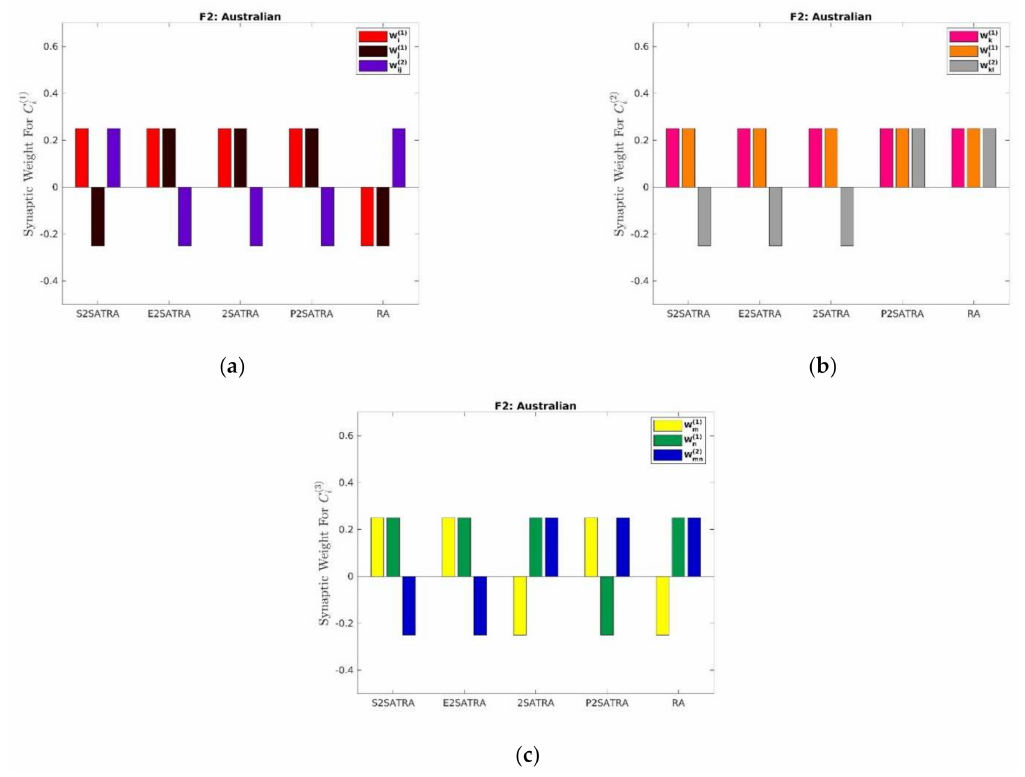
( 1 ) ( 2 ) ; ( b ) C and ( c ) C i i